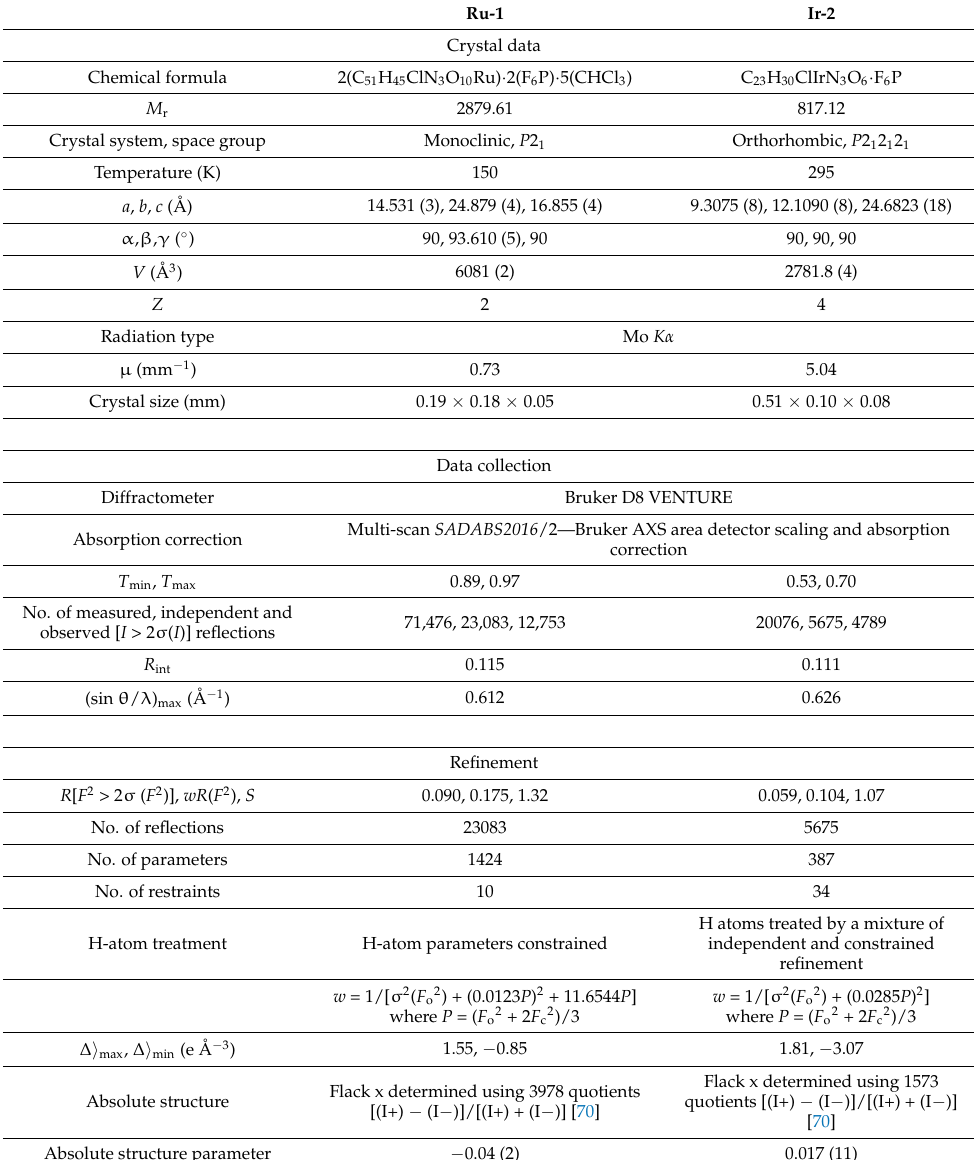
Table 6. Experimental details of X-ray structure